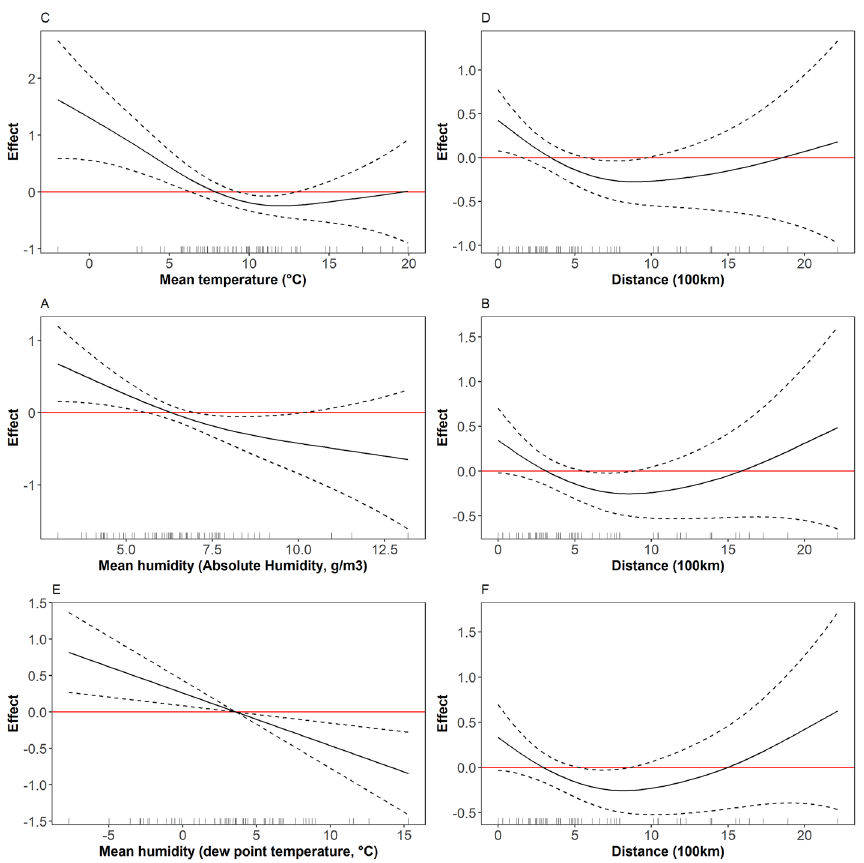
Figure 6. Non-linear effects for weather parameters obtained in the multivariable model for R 0 analysis (see Table 1 for linear effects). ( A ) Temperature, model 1. ( B ) Distance to first region affected, model 1. ( C ) AH, model 2. ( D ) Distance to first region affected, model 2. ( E ) DP, model 3. ( F ) Distance to first region affected, model